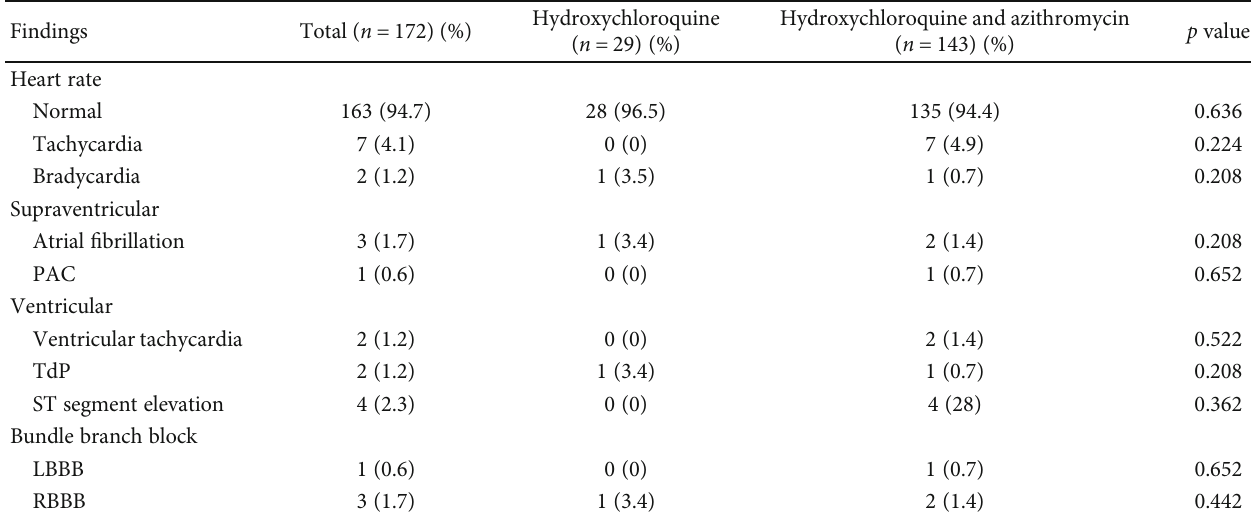
Table 3: Posttreatment electrocardiographic fi ndings of COVID-19